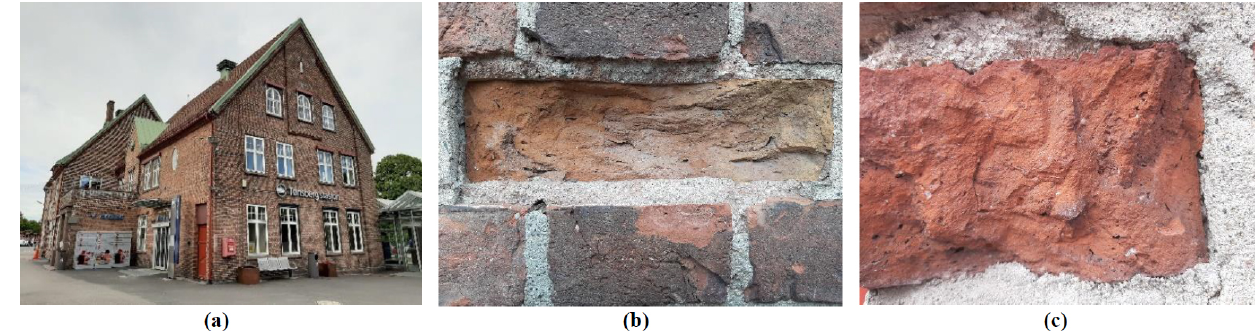
Figure 4. The (a) Tønsberg train station and degraded bricks at its walls with (b, c) southeast